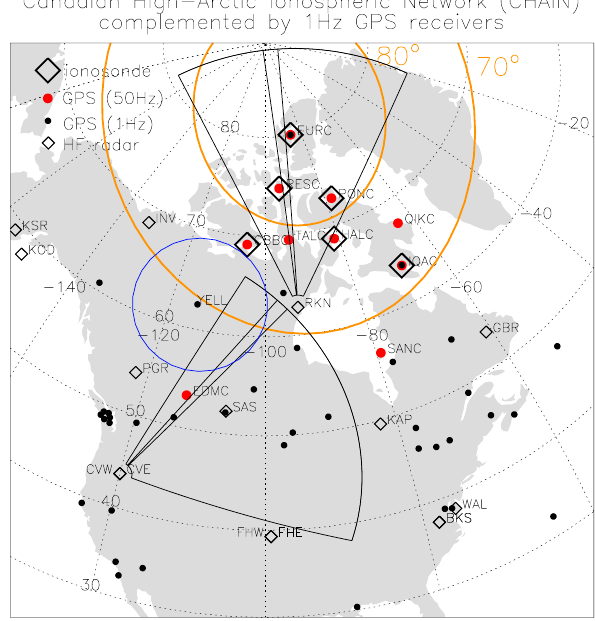
Fig. 1. Canadian High Arctic Ionospheric Network (CHAIN) com- plemented by other GPS receivers recording at sampling rate of 1Hz. Fields of view of an all-sky imager in Yellowknife and Su- perDARN radars in Rankin Inlet and Christmas Valley East with beams 6 and 3, respectively, are shown. Locations of other Super- DARN radars are indicated by diamonds. The corrected geomag- netic (CGM) latitudes 70 and 80 ◦ , in yellow, are superposed over the geographic grid in dotted line.